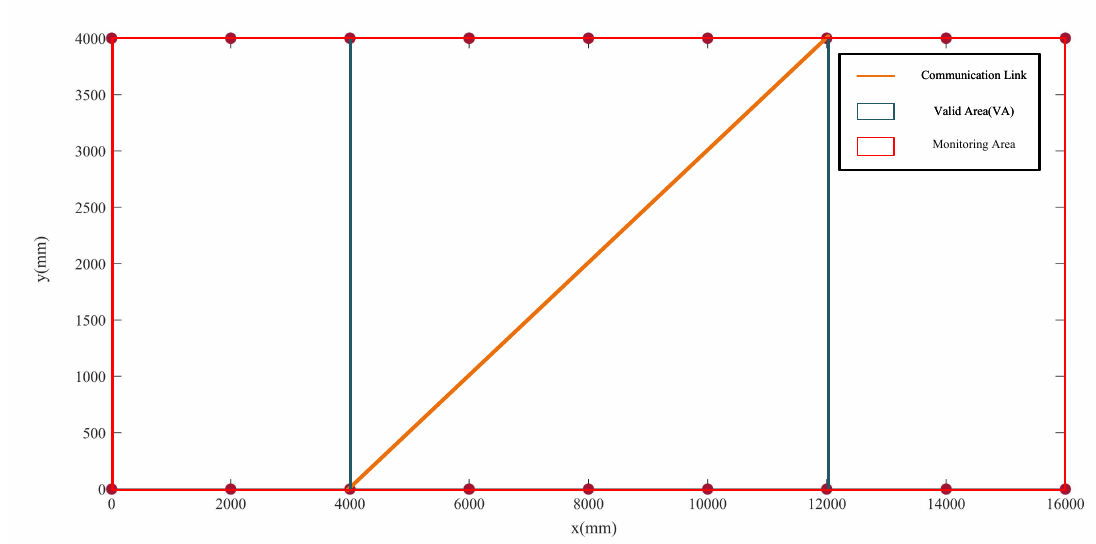
Figure 7. Valid area of the communication link.